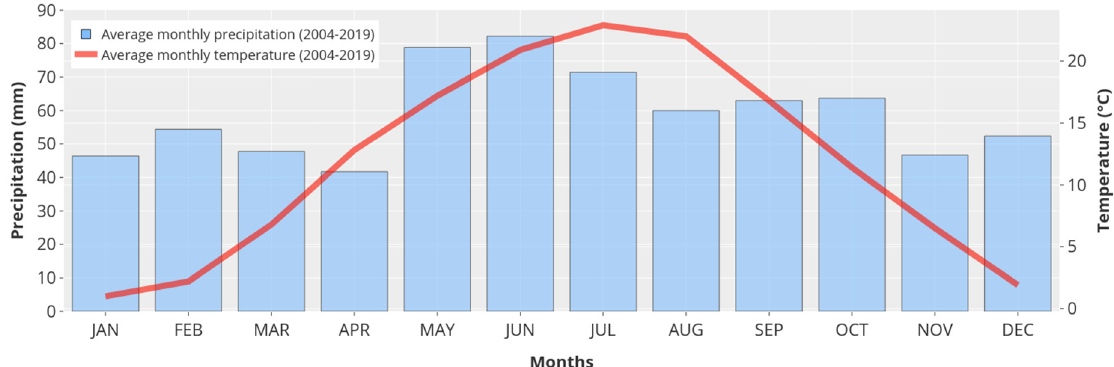
Figure 2. Monthly average precipitation and temperature between 2004 and 2019. The data is obtained from the Beli Manastir meteorological station (45°47 ′ N, 18°36 ′ E, 9 m above sea level.). The meteorological station is located 6.7 km from the studied hazelnut orchard.